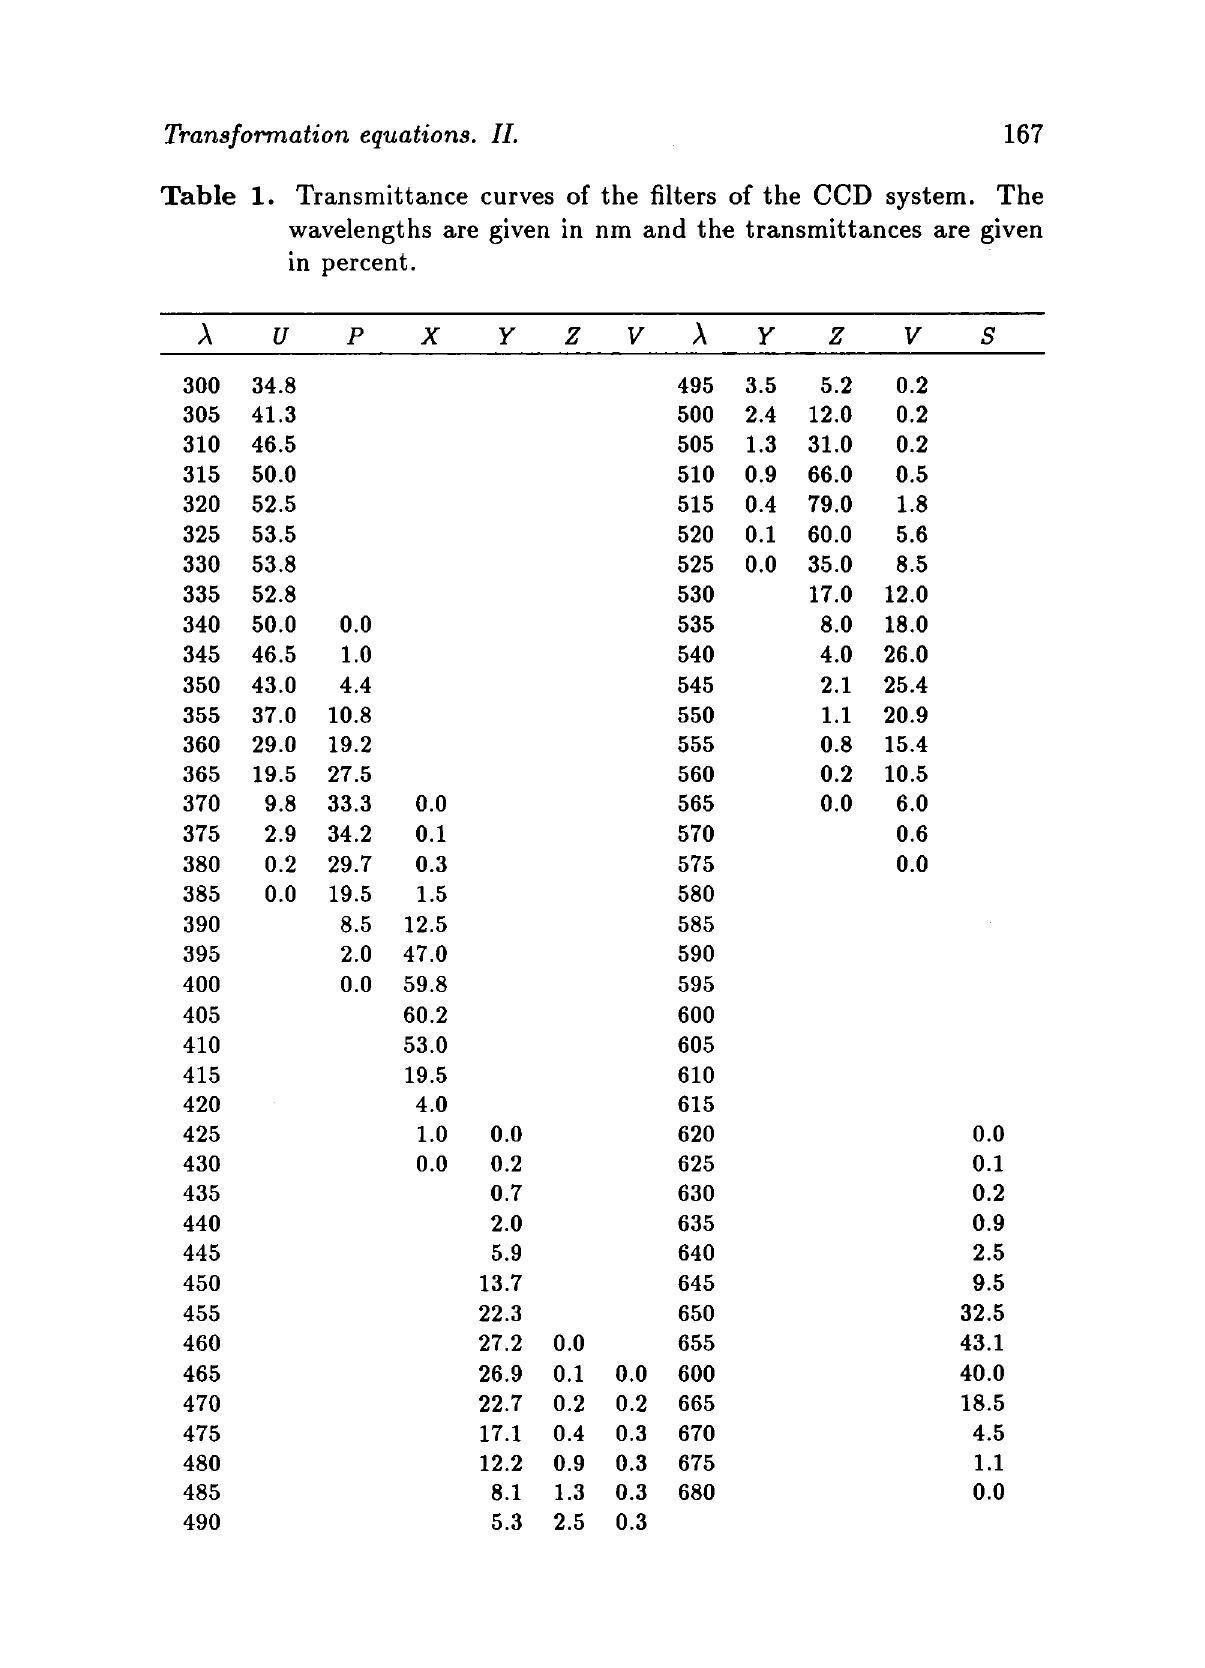
Table 1. Transmittance curves of the filters of the CCD system. The wavelengths are given in nm and the transmittances are given in